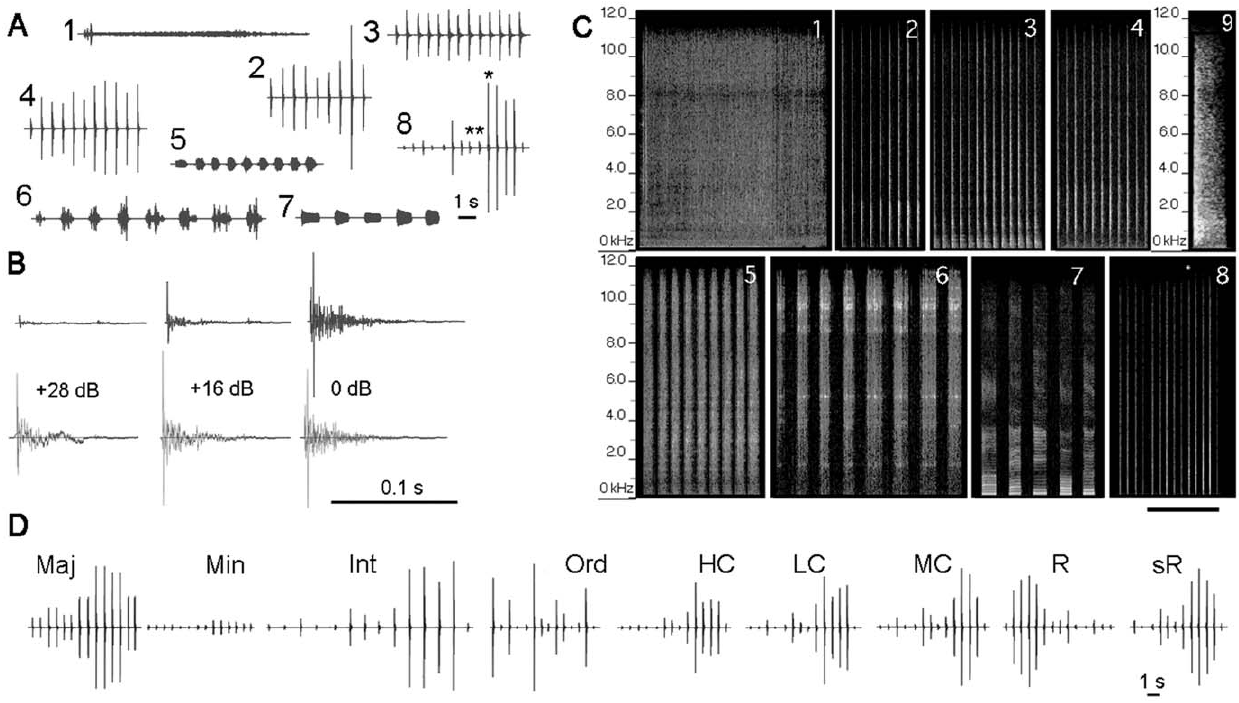
Figure 1. Sound stimuli used for training and the recognition tests. A , Waveforms of the training stimulus set, including non-target (1–7) and target sounds (8). Food is associated only with the target sound. Sound type: 1, tap water flowing in a sink; 2, clapping hands; 3, hitting a plastic carrier; 4, hitting a metal cage; 5, scratching a metal mesh; 6, jingling keys; 7, human vowels; and 8, human footsteps. B , Details of the envelope shape of individual segments of the step target sound. In the upper panels, the time (horizontal) axis is expanded for the 8th, 9th and 10th segments (asterisks in A –8), while in the lower panels, the amplitude (vertical) axis is enlarged by the value shown in dB. C , Spectrograms of the stimulus sounds. The numerals correspond to those shown in A . The 10th segment of the step sound (asterisk in c–8), expanded in time, is shown in C–9. The energy level is represented by a gray scale, with white for the highest level and black for the lowest level. Note that all the stimuli except the vowels (7) show non-harmonic noise-like spectra. The calibration is 5 s for all panels except for panel 9 (0.25 s). D , Waveforms of the stimulus set used for recognition tests. ‘‘Maj’’ and ‘‘Min’’; modified step sounds with 7 major and minor segments of the step sound doubled. ‘‘Int’’; modified step sound with the intersegment intervals expanded. ‘‘Ord’’; modified step sound with segment-order shuffled. ‘‘LC’’, ‘‘MC’’ and ‘‘HC’’; modified step sounds with the low-, mid-, and high-frequency ranges removed from the step sound, respectively. ‘‘R’’ and ‘‘sR’’; modified step sounds with the entire sound reversed in time and with individual segments locally time-reversed without changes in their order, respectively.